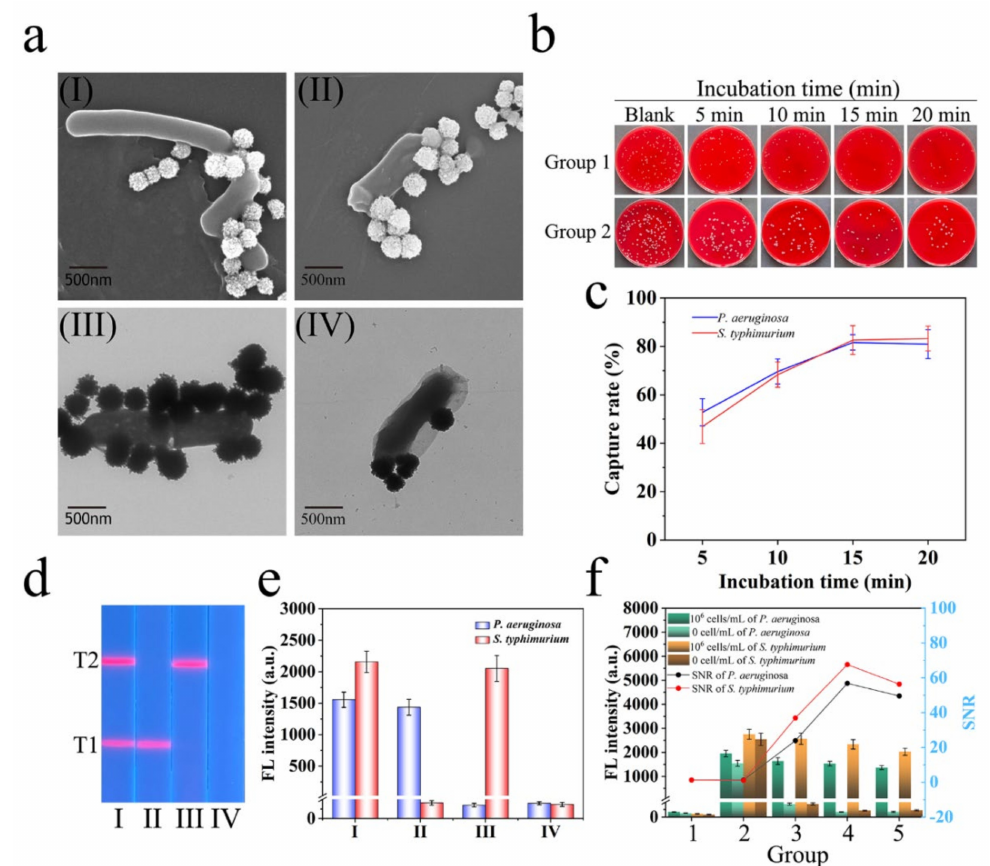
incubation. Figure S5 shows the capture efficiency of Mag@QDs-WGA for P. aeruginosa at different pH values of 2–12. The results showed that Mag@QDs-WGA exhibited high and stable capture capacity in a wide pH range of 3–11.